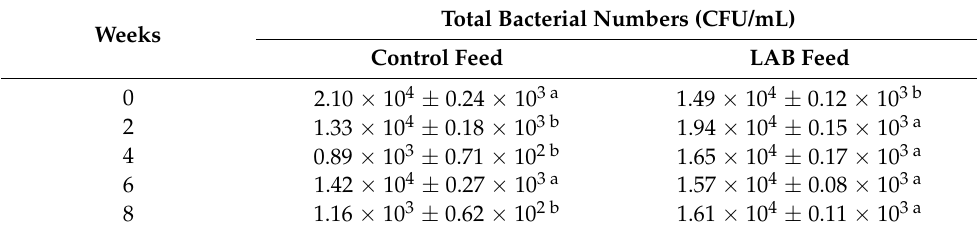
Table 3. The total bacterial numbers in environmental